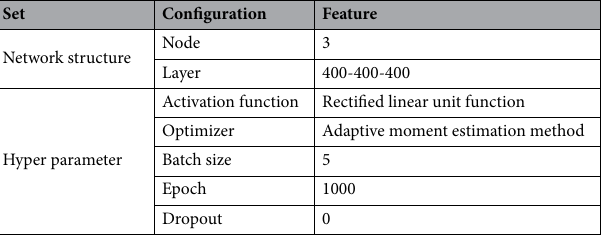
Table 4. Final network structure and hyper-parameter.